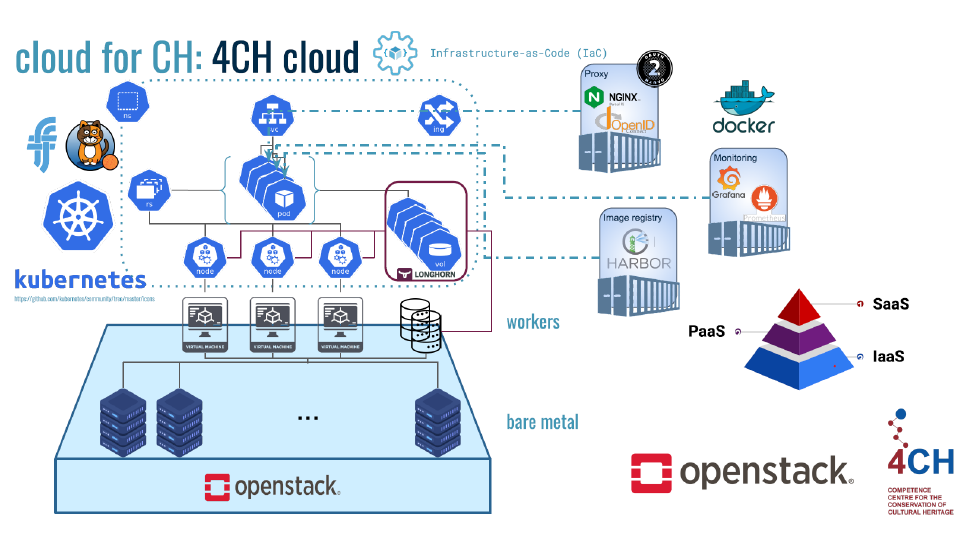
Figure 10. Schema of the 4CH competence centre cloud PaaS, also showing the ancillary software